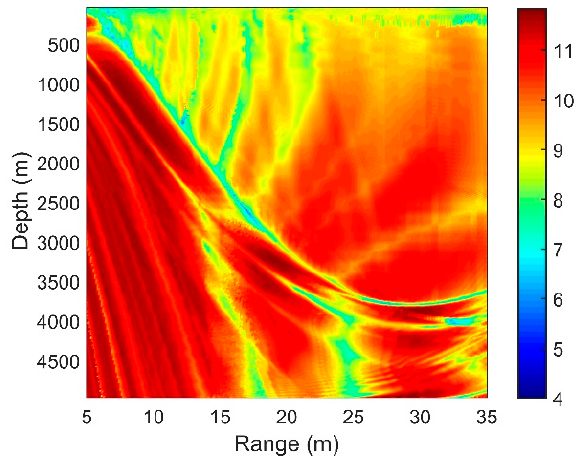
Figure 6. The SG with different array locations for a source at a 100-m depth.